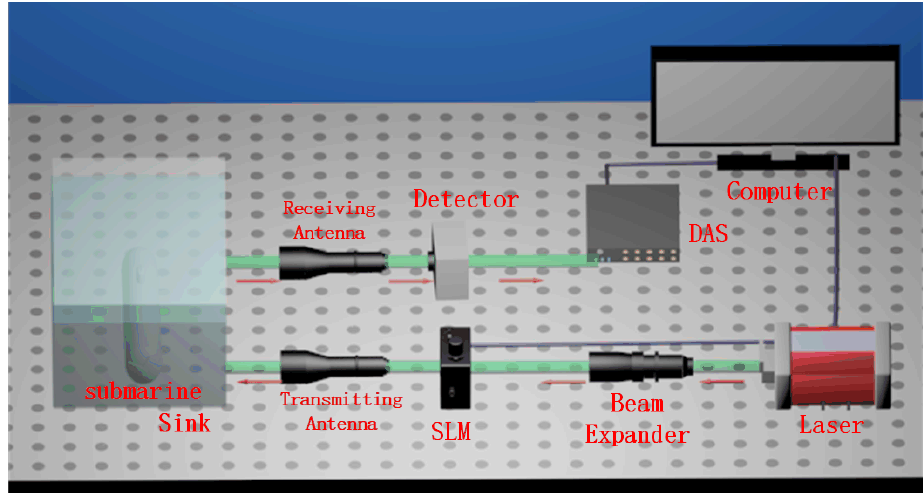
Figure 1. Schematic of UDGI-FS system.